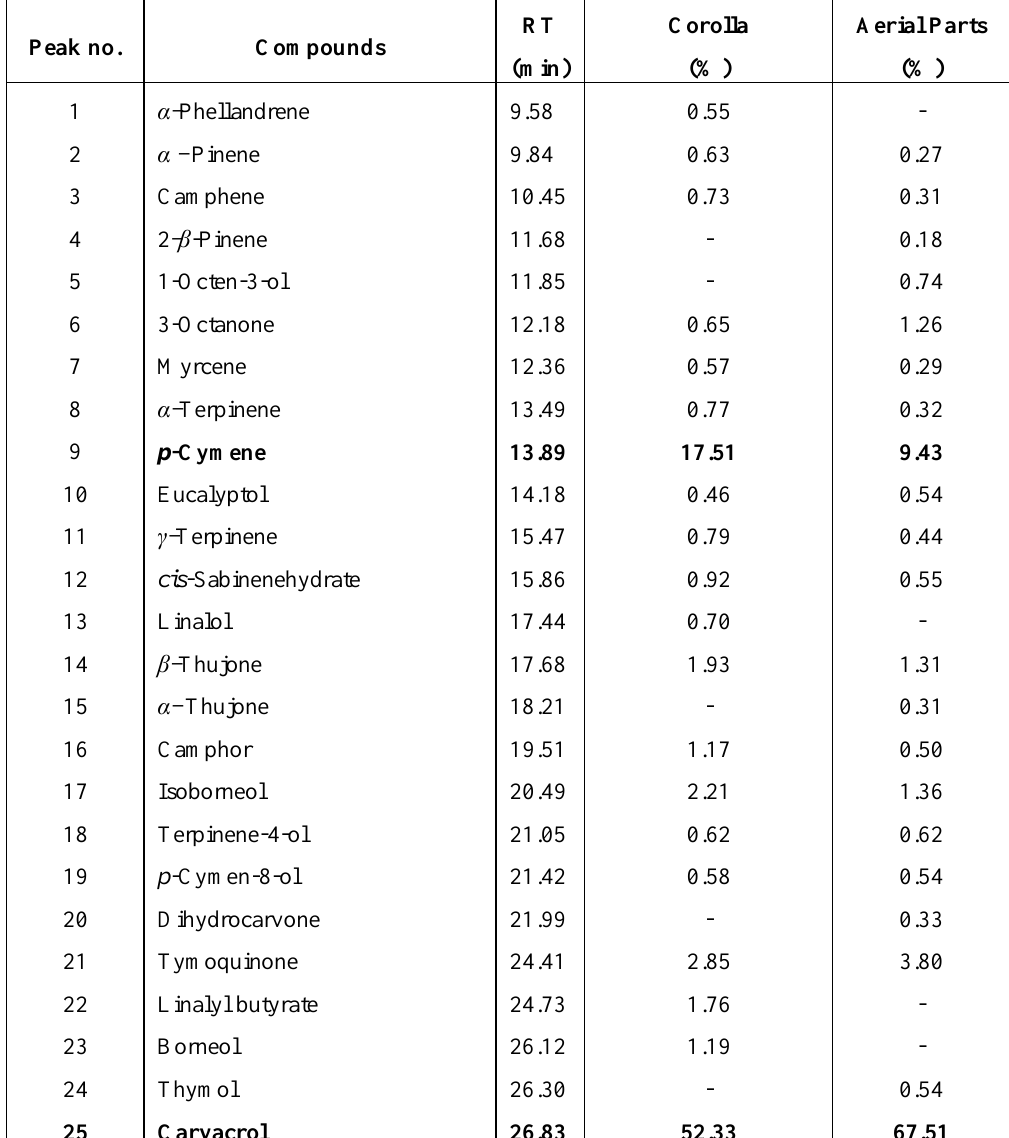
Table 1. Chemical compositions (%) of essential oil in corolla and aerial parts of O. acutidens. Peak